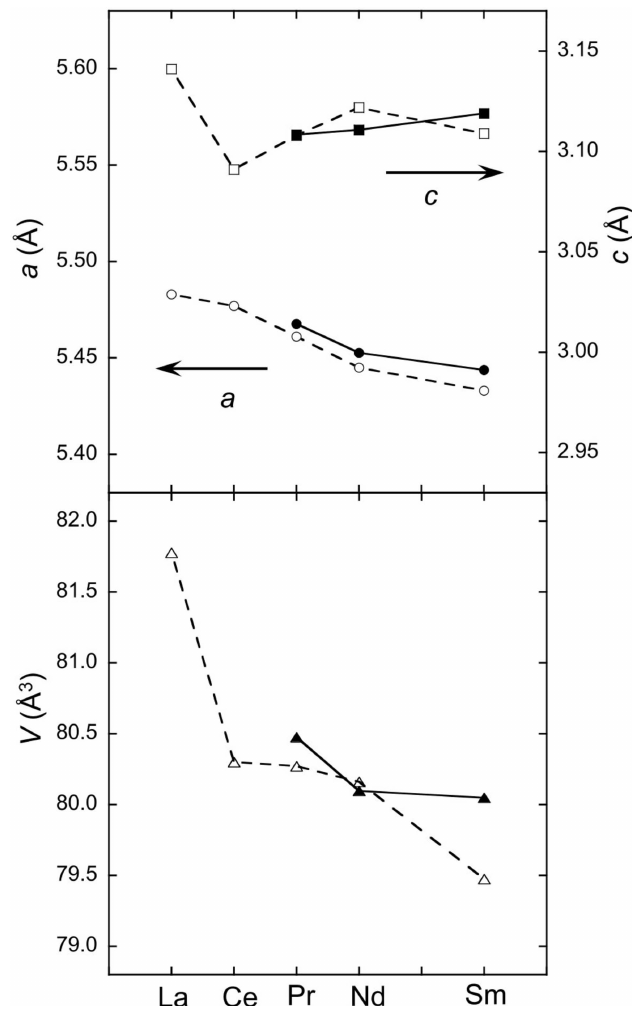
Figure 1 Structure of RE Rh 3 B 2 compounds (space group: P 6 /mmm ) as viewed along the c axis. B and RE atoms settle in the center of the trigonal and hexagonal prisms, respectively.